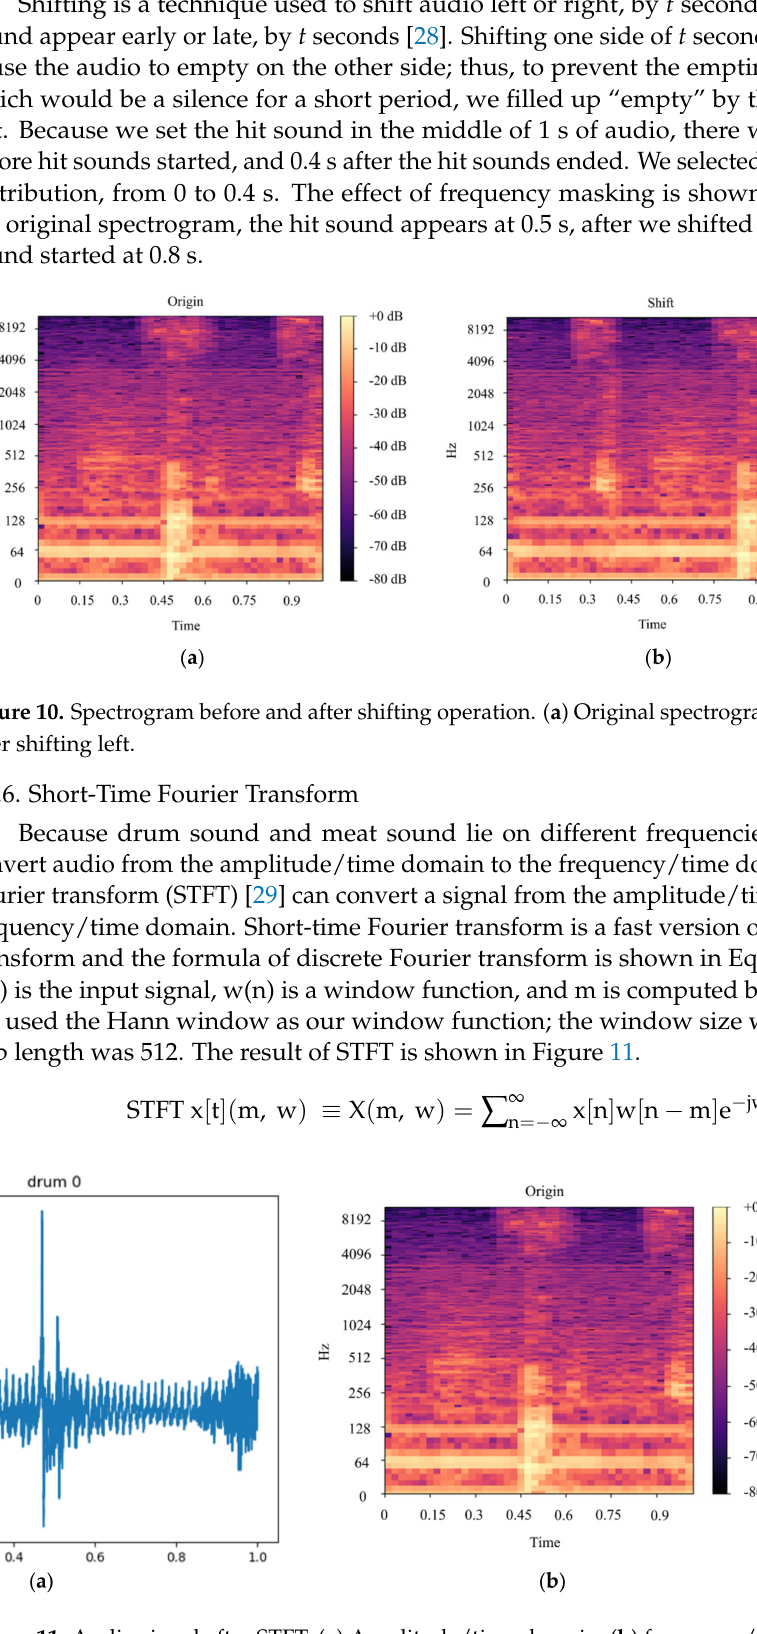
Figure 11. Audio signal after STFT. ( a ) Amplitude/time domain, ( b ) frequency/time